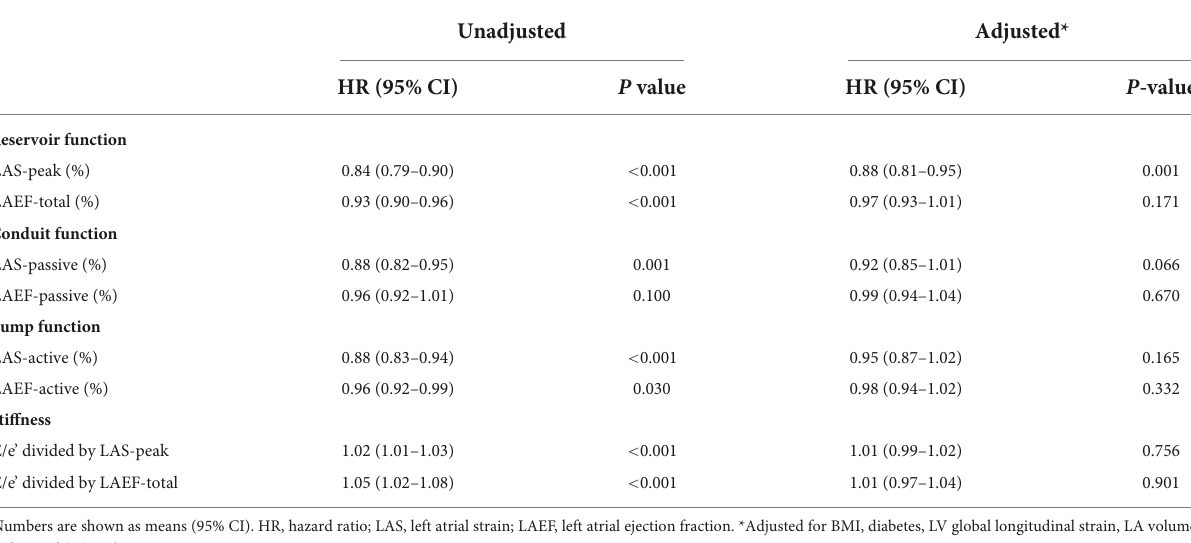
TABLE 4 Univariate and multivariate Cox proportional hazards analysis.